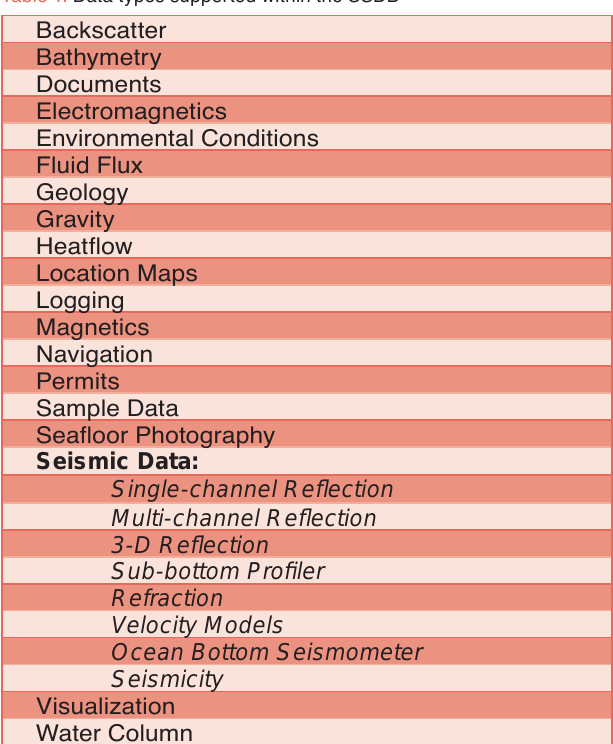
Table 1. Data types supported within the